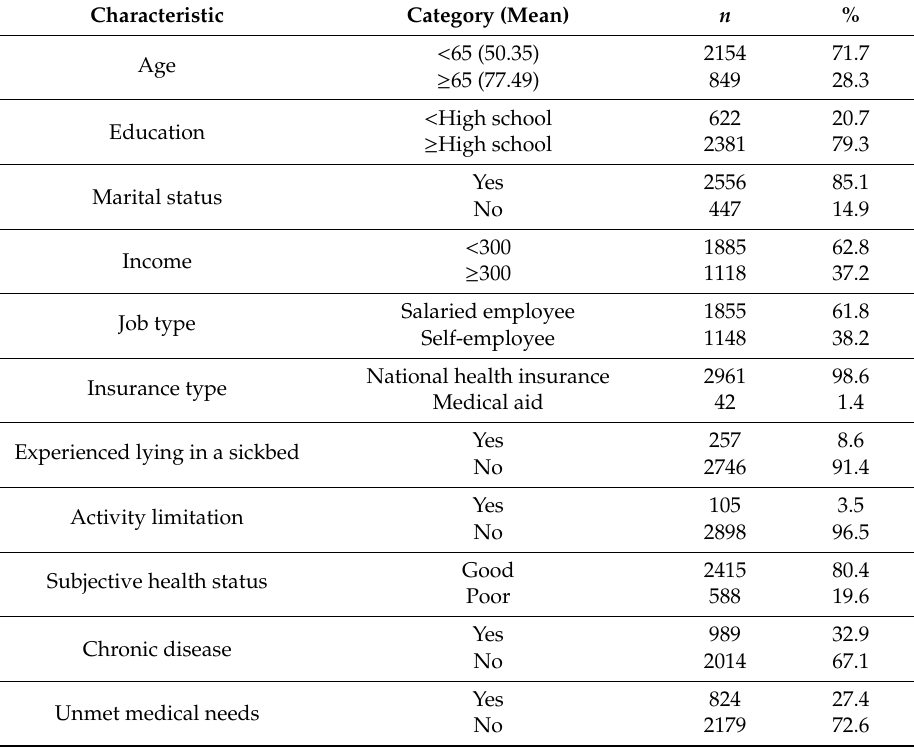
Table 1. Characteristics of the patients ( n = 3003).